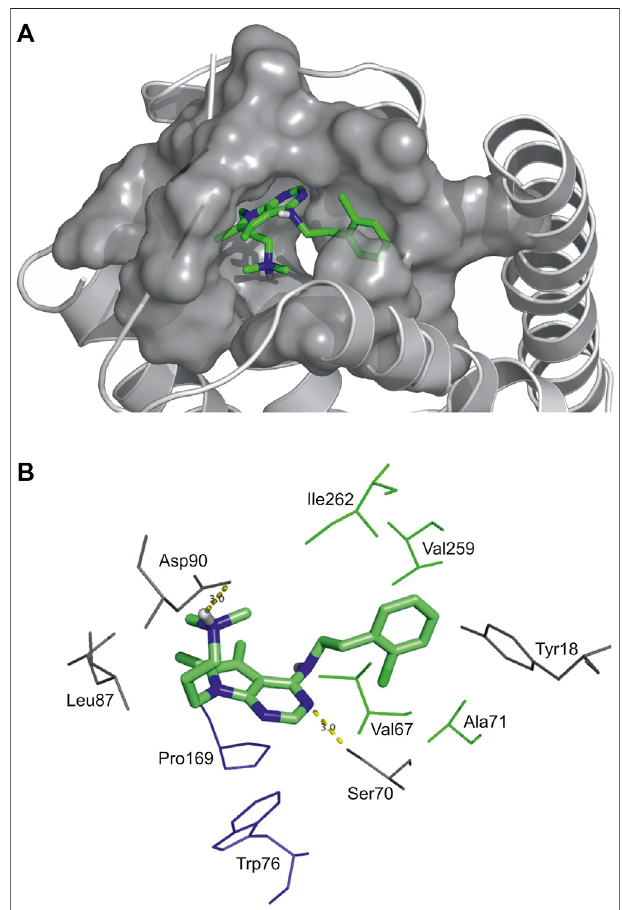
FIGURE 2 | High af fi nity binding pocket with Compound 2 in SST 4 receptor (A) ,BindingpatternofCompound2:hydrophobicpocketcomposed of Val67, Ala71 in TM2, Val259 and Ile262 in TM7, aromatic-aromatic interactions with Pro169 and Trp76, H-bonds (yellow) with Asp90 and Ser70 (B)